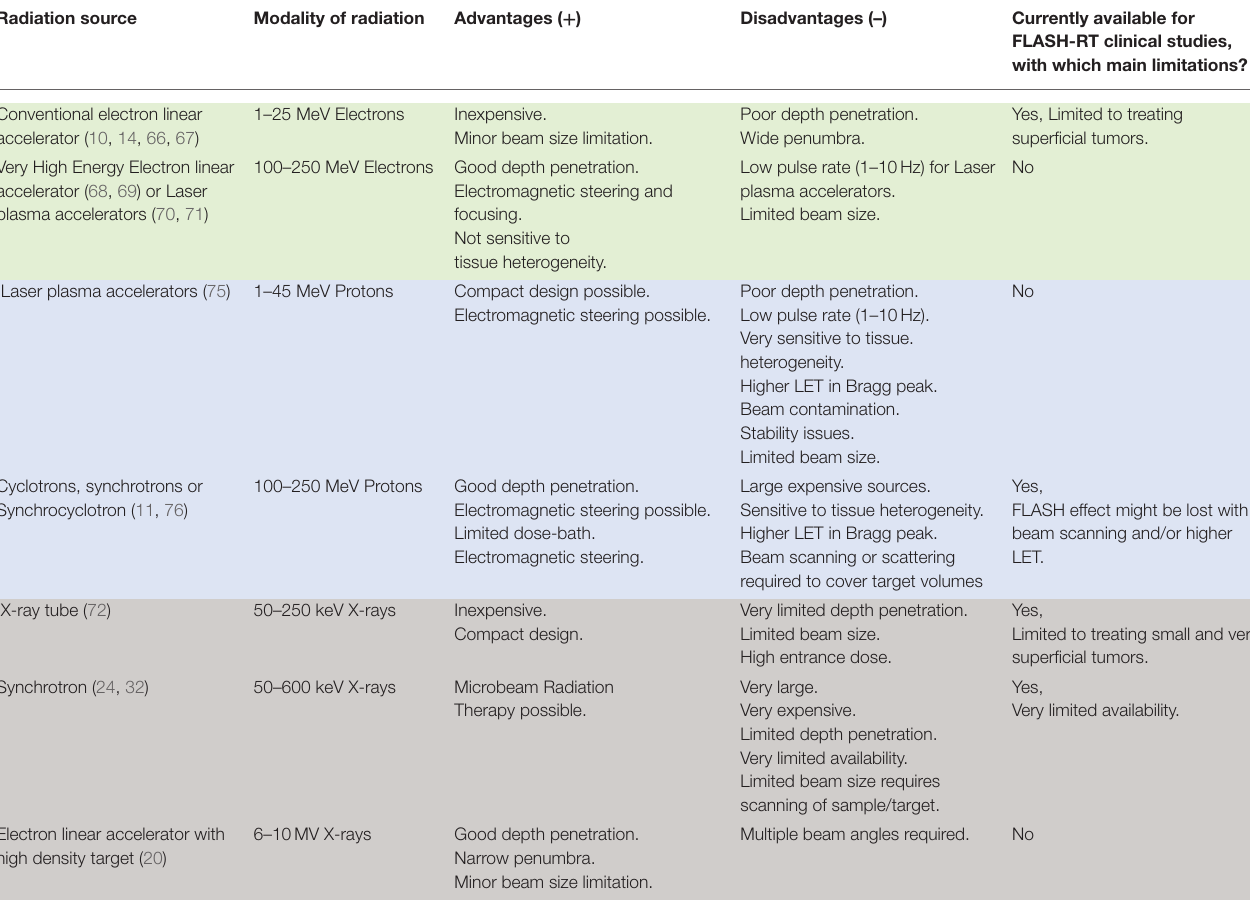
TABLE 3 | Some relevant advantages and disadvantages of current and prospective FLASH radiotherapy sources (color coded by radiation